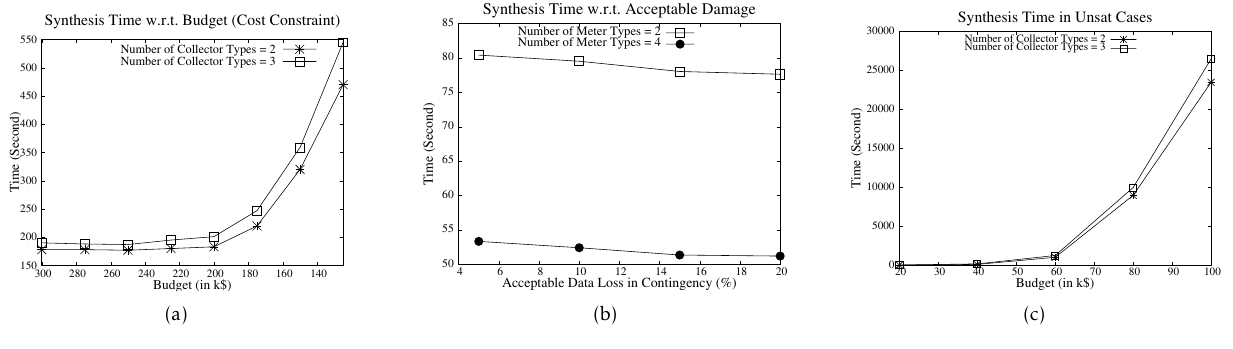
Synthesis Time w.r.t. Budget (Cost Constraint)